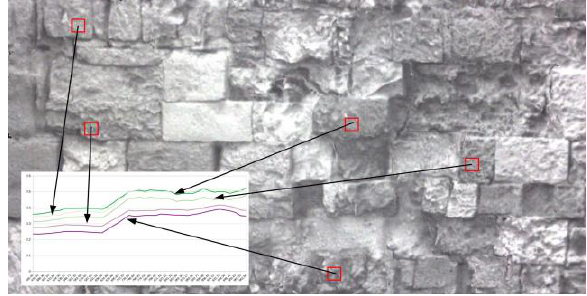
Figure 7 . Detailed 3D Textured Model (HS) and spectral signatures of stones with various degradation levels.